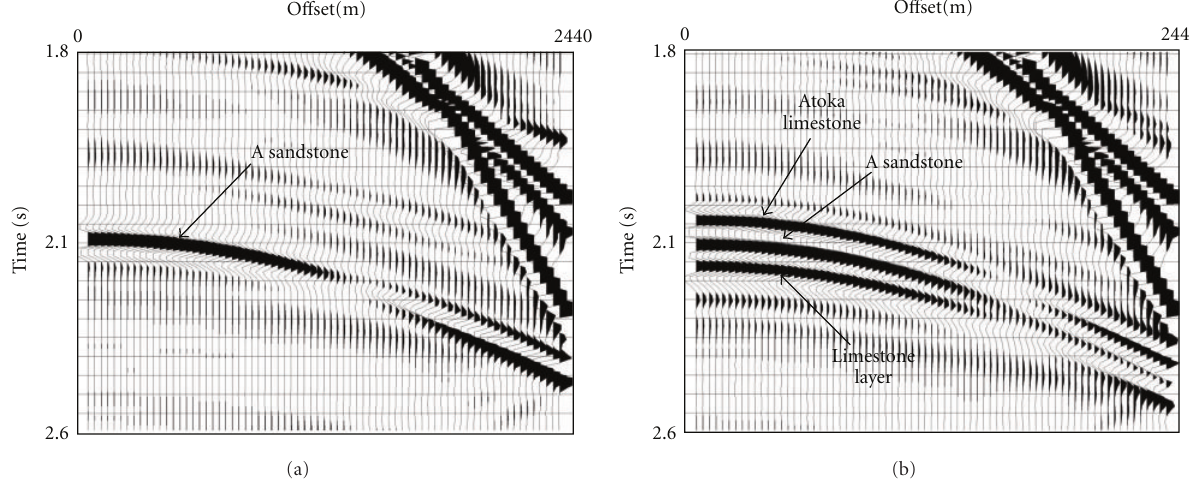
Figure 13: (a) S-wave gather for Model 1a shows a strong peak response at the top of Morrow A sandstone which changes to trough with o ff set. (b) The S-wave gather for Model 3a shows that even in the presence of overlying shale and bottom limestone layer the Morrow A sandstone shows a distinct high amplitude AVO